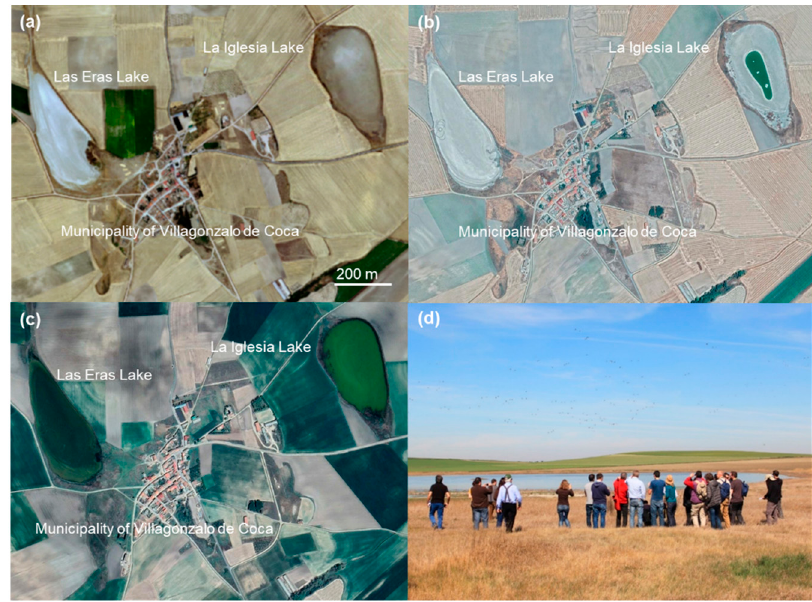
Figure 7. La Iglesia and Las Eras lakes. Situation in ( a ) 2004, before the restoration works (PNOA 2004 flight); ( b ) August of 2017, during the driest season of the year (Google Earth); and ( c ) April of 2021, when the lake reaches its maximum extension (Google Earth). Figure ( d ) shows a panoramic view of La Iglesia Lake during a MARSOL consortium visit in March 2015.